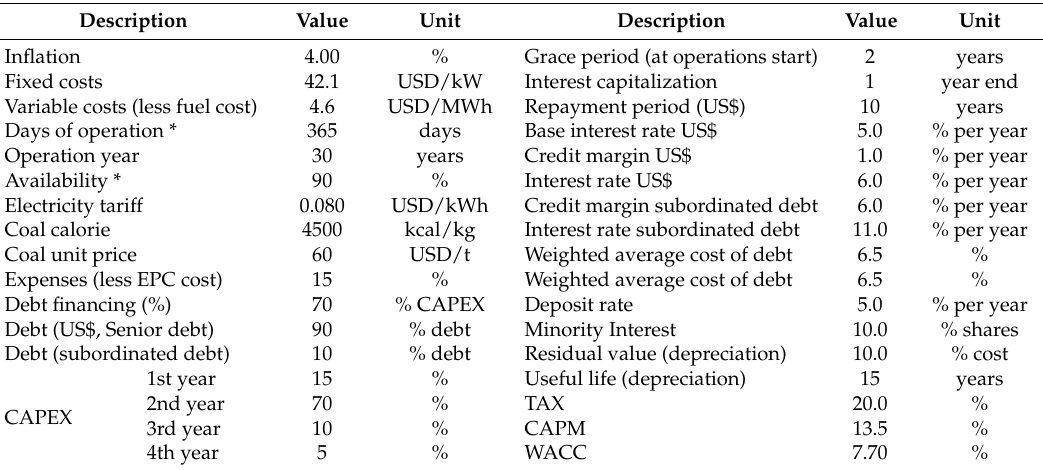
Table 4. Assumptions used in economics analysis.